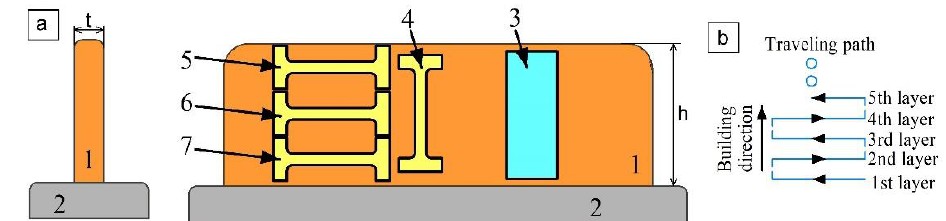
Figure 2. Sample preparation scheme ( a ) and EBAM layer deposition strategy ( b ) 1—Cu-7.5wt.%Al bronze wall; 2—stainless steel substrate; 3—microstructural characterization sample; 4—sample with tensile axis orientation along the wall height; 5–7—samples with tensile axis orientation perpendicular to the wall height (along the layer deposition direction); t—wall thickness; h—wall height.